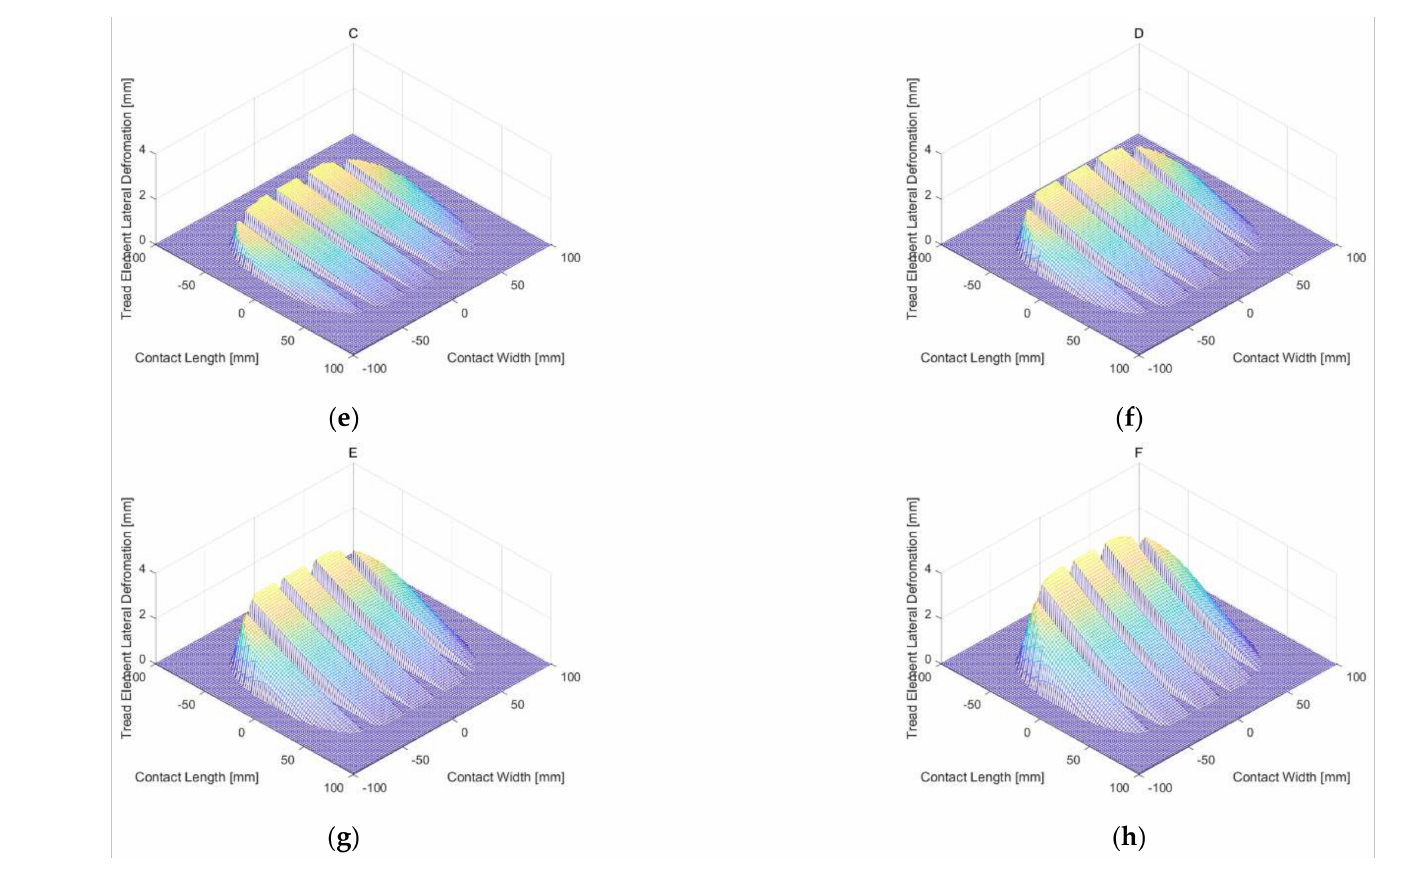
Figure 19. Lateral deformation of the tread element at different traveling distances under the step side slip angle input. ( a ) Response of lateral force and aligning moment. ( b ) Deformation of the tread element at the contact patch center line under different travel distance. ( c ) Deformation of the tread element at A position. ( d ) Deformation of the tread element at B position. ( e ) Deformation of the tread element at C position. ( f ) Deformation of the tread element at D position. ( g ) Deformation of the tread element at E position. ( h ) Deformation of the tread element at F